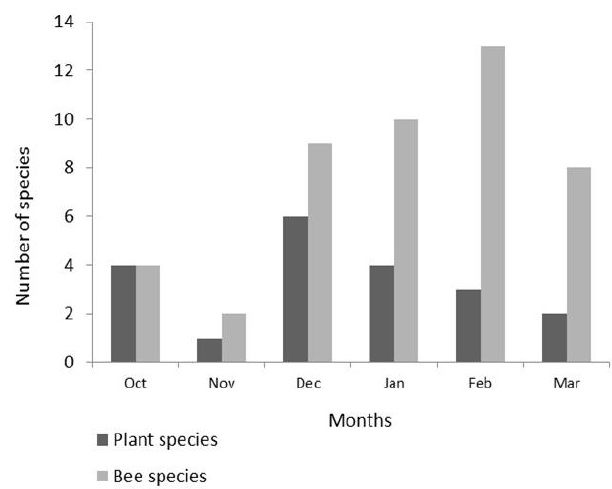
Fig 1 . Plant and bee species richness in a savannah area in